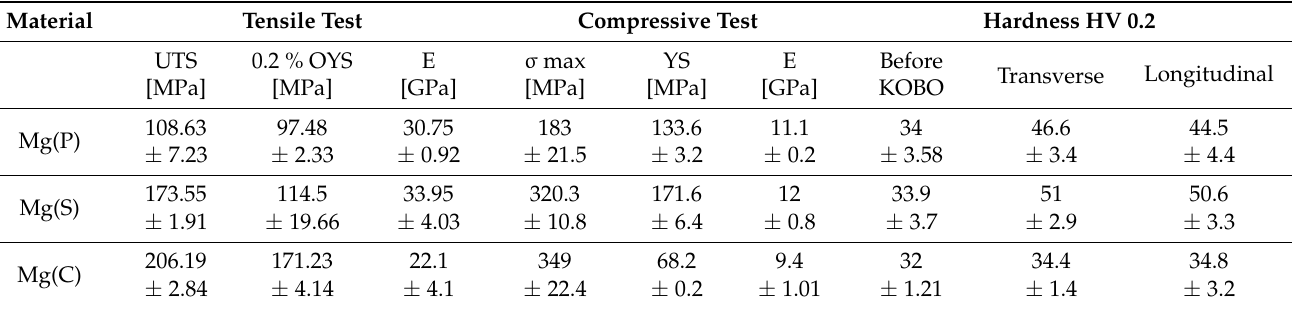
Table 4. Results of tensile and compressive strength tests and HV0.2 measurements determined for KOBO-extruded